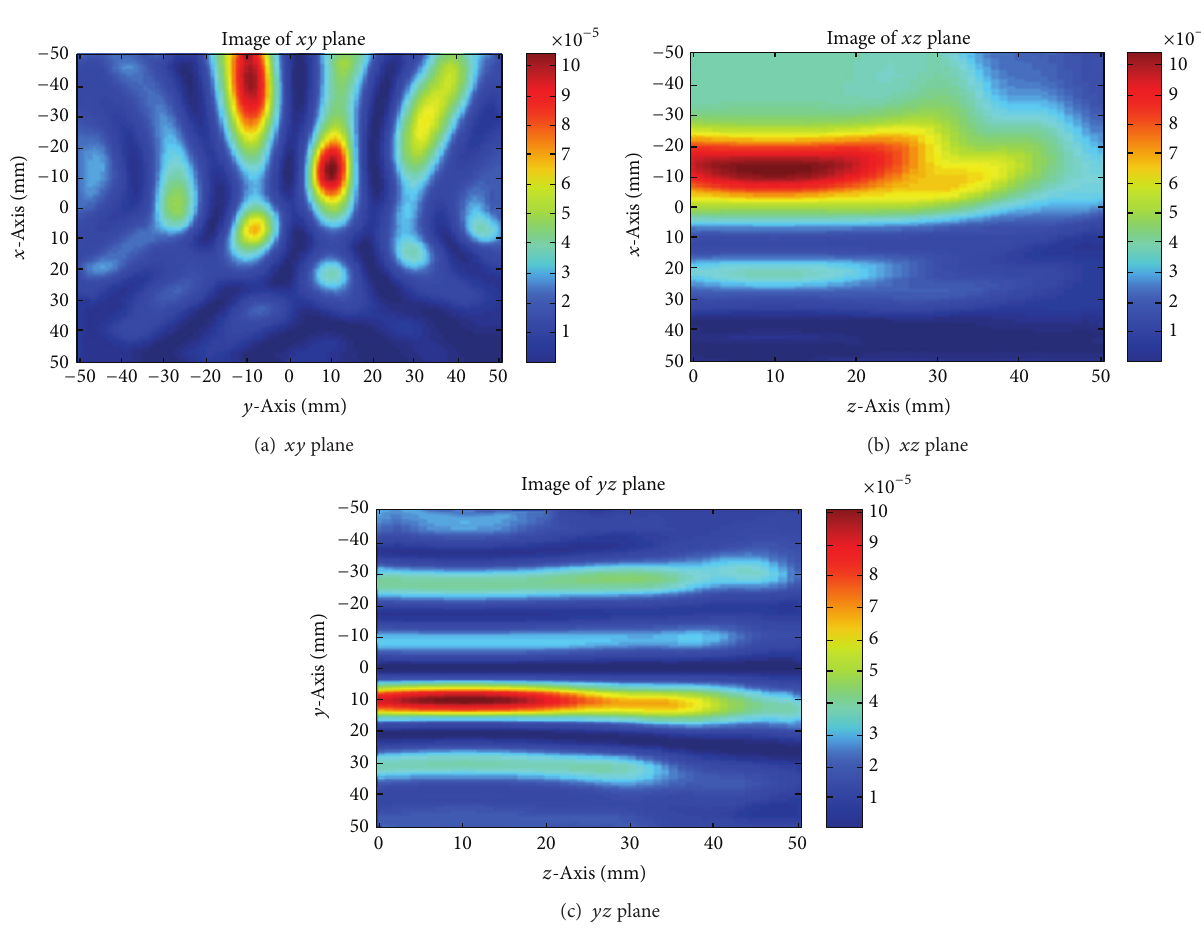
Figure 9: Breast images of changing precise time